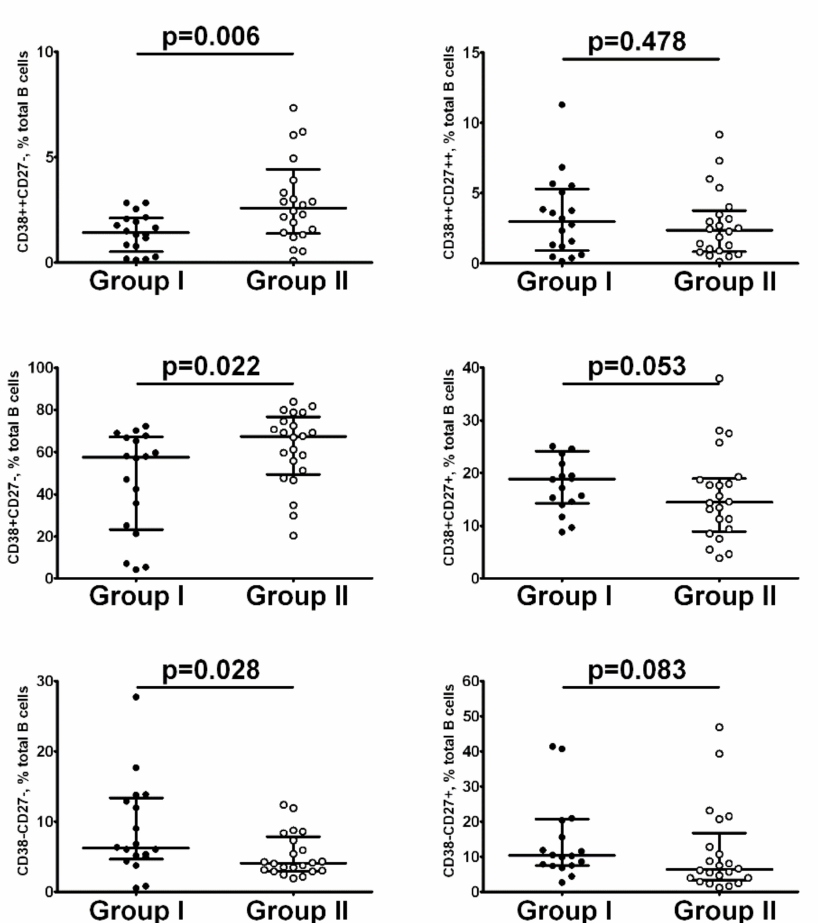
Figure 5. The impact of 100,000 IU cholecalciferol supplementation on B cell subset frequencies on the 9th day of hospitalization. Black circles—patients from Group I ( n = 18); open circles—patients from Group II ( n = 22). Numbers represent the percentages of the indicated B cell subset among the total B cell population. Each dot represents individual subject. Horizontal bars depict the group medians and interquartile ranges (Med (Q25; Q75)). Statistical analysis was performed with the Mann–Whitney U